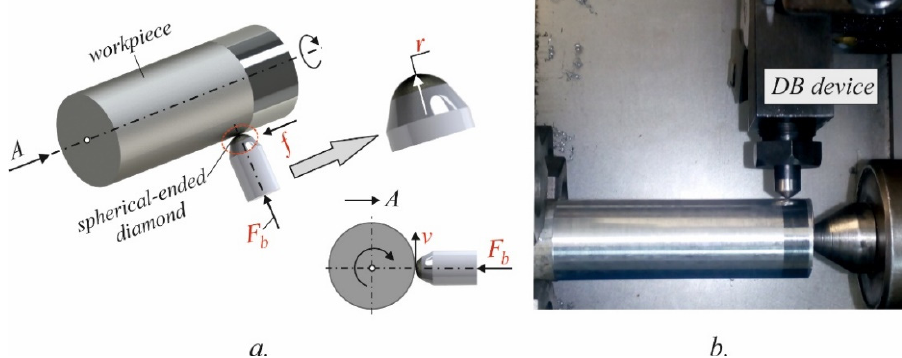
Figure 4. Diamond burnishing: ( a ). kinematic scheme; ( b ). implementation on CNC T200